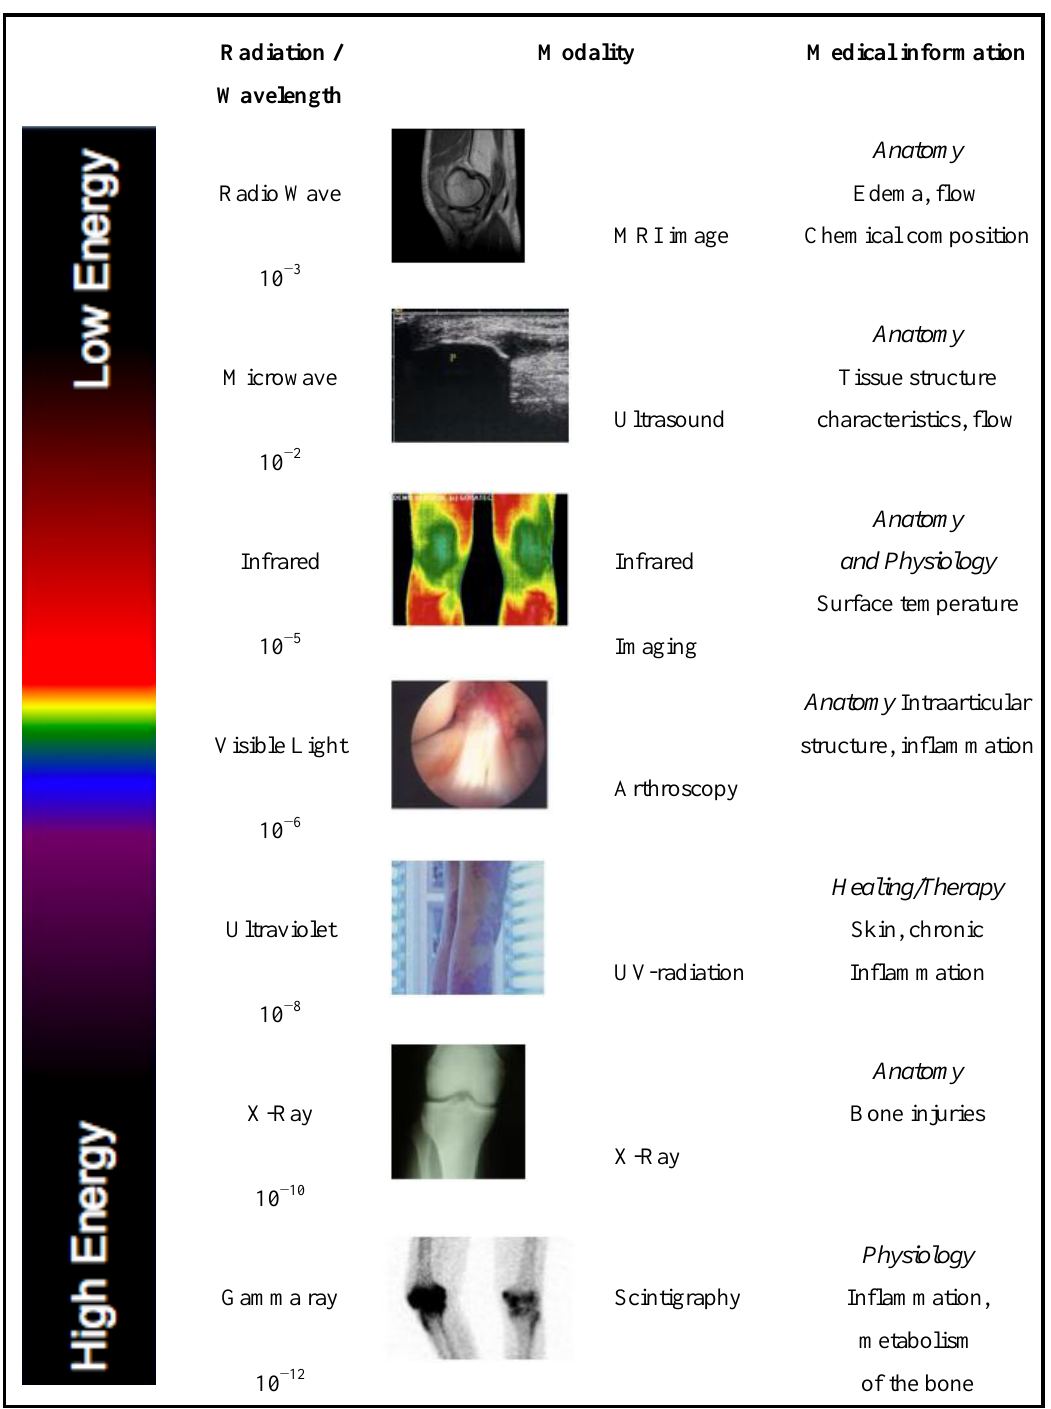
Figure 1. Typical imaging modalities within the electromagnetic